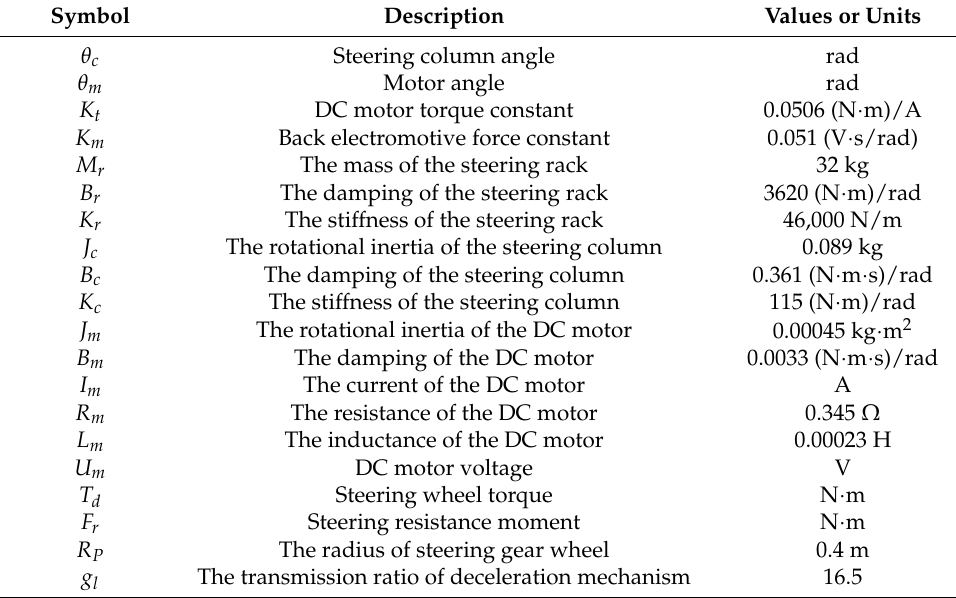
Table 1. The variables of Equations